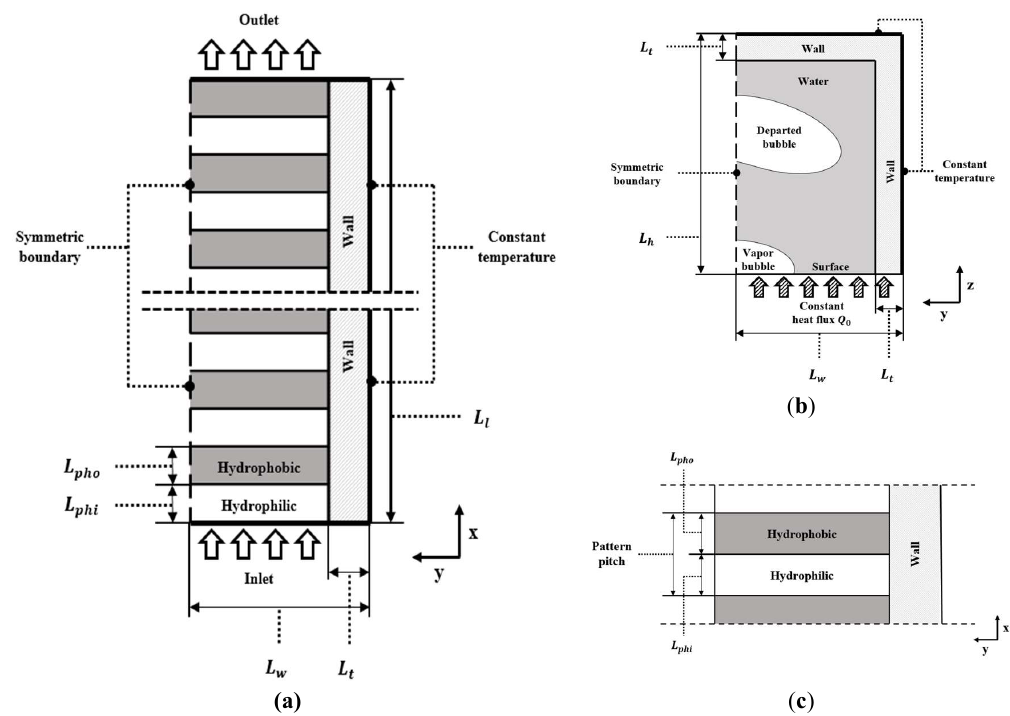
Figure 2. ( a ) Simulation domain description of the x-y plane at z = 0. ( b ) Simulation domain description of the y - z plane at x = 0. ( c ) Pattern wettability description of the x - y plane at z = 0.